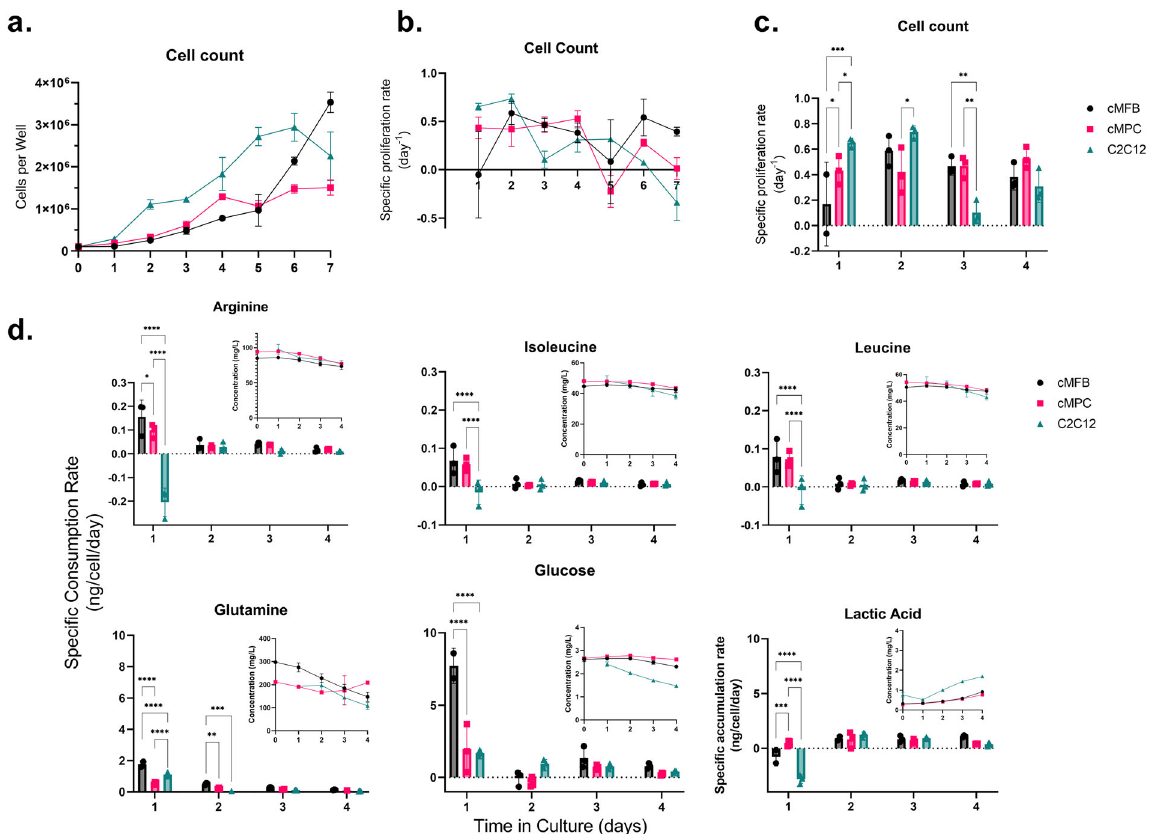
Fig. 6 Speci fi c growth and utilization rates. The speci fi c cellular growth and nutrient utilization rates were calculated based on the spent media analysis data by fi nding the ratio of the approximate backward numerical derivatives for the cell count and nutrient concentration data to the cell count at the corresponding time point. a The total cell counts per well for the three cell types are plotted on a linear scale as a frame of reference. b The speci fi c cellular proliferation rates are plotted as a line graph with the three cell types overlaid for the fi rst 7 days of culture. c The same speci fi c cellular proliferation rate data are plotted as a bar graph for the fi rst 4 days of culture, allowing for visualization of the statistical differences between the three cell types. d The speci fi c consumption rates of fi ve key nutrients are plotted separately in bar graphs to compare the three different cell types. The speci fi c accumulation rate of lactic acid is also included. Arginine, isoleucine, and leucine are plotted on y -axis scales up to 0.3 ng/cell/day, while glutamine, glucose, and lactic acid are plotted with scales ranging up to 10 ng/cell/day. Each bar graph includes an overlaid line graph showing the measured concentrations of the corresponding media component in mg/L as a reference. All error bars represent standard deviation. Statistical analysis for the speci fi c proliferation rate and speci fi c consumption rate data was performed using two-way analysis of variance (ANOVA) followed by the Holm- Š ídák post-test for multiple comparisons with α = 0.05 (ns, not signi fi cant. * p < 0.05. ** p < 0.01. **** p <